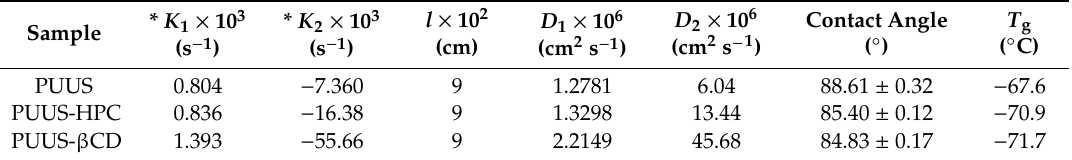
Table 2. Di ff usion coe ffi cients, contact angle values and glass transition temperatures resulted from the experimental data for polyurethane based nanofibrous composite mats.